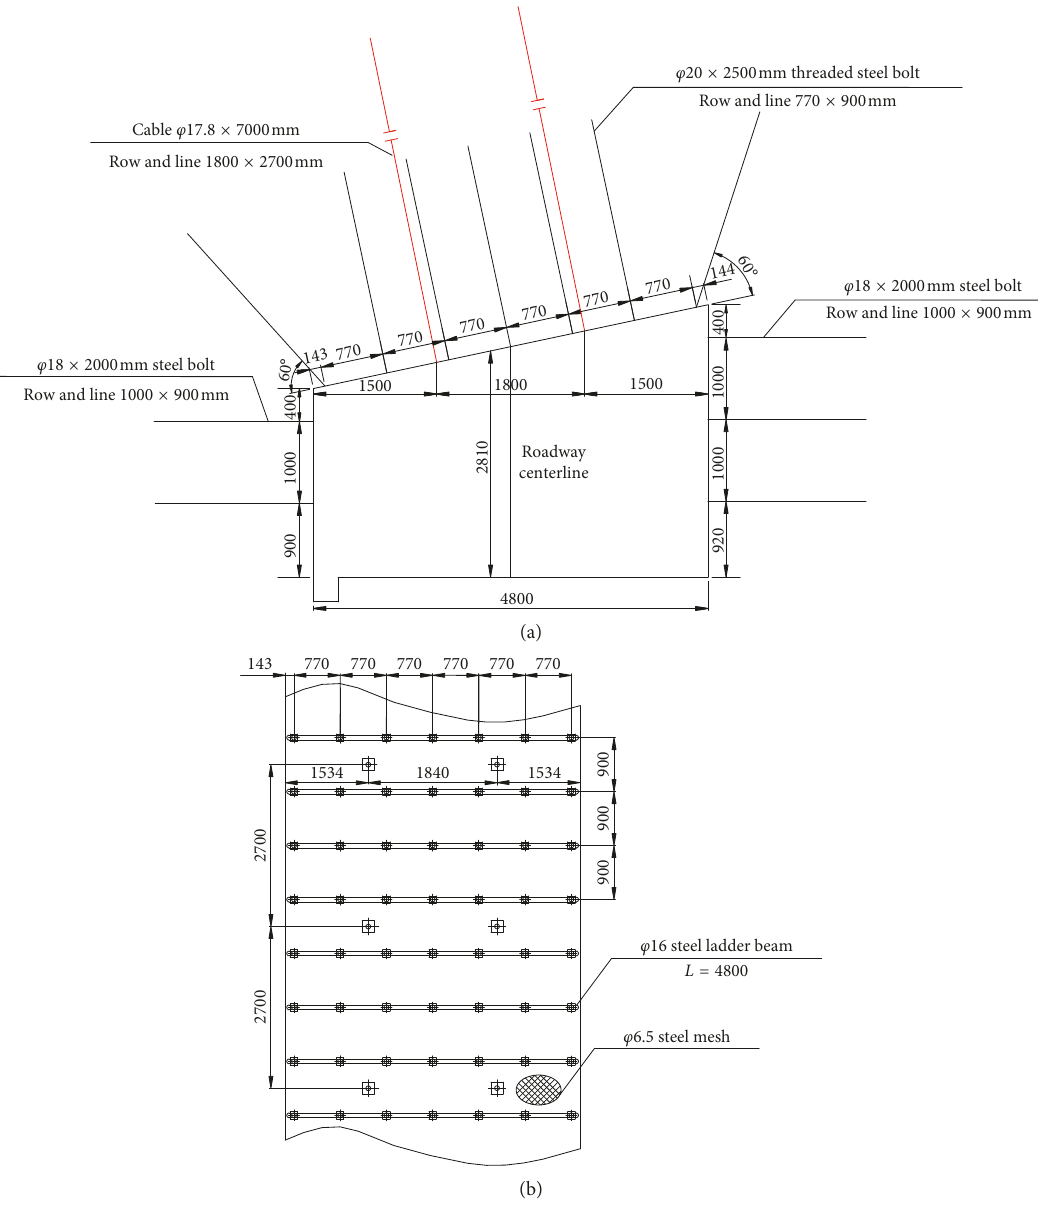
Figure 11: 051606 ventilation way supplement support scheme. (a) Elevation view of support scheme. (b) Horizontal projection of support